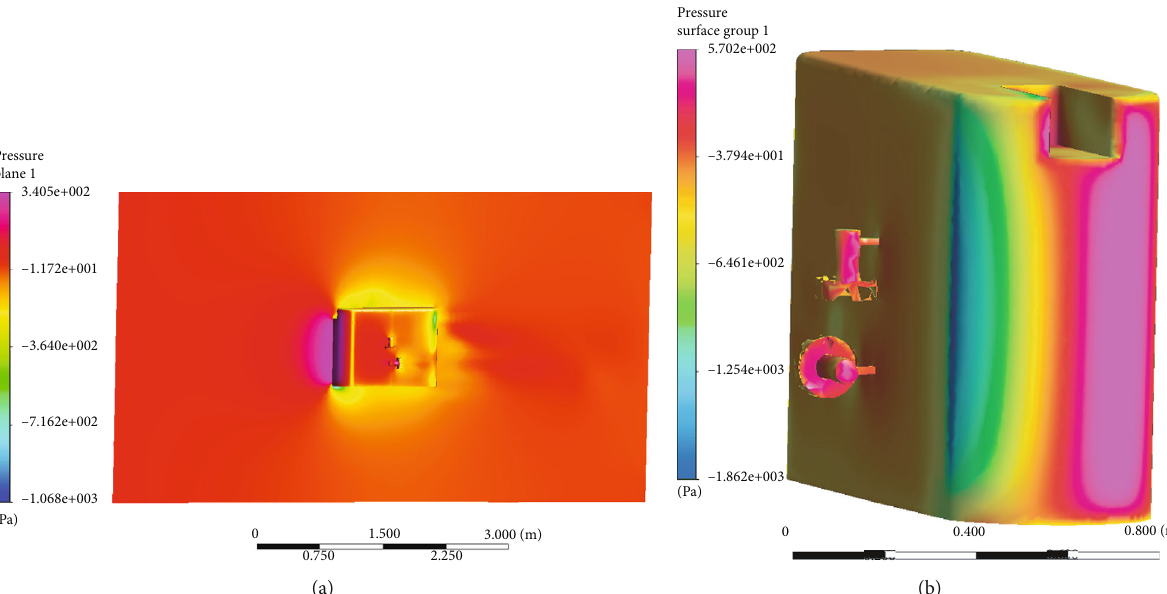
Figure 6: Pressure contour: (a) in entire simulation area; (b) in the